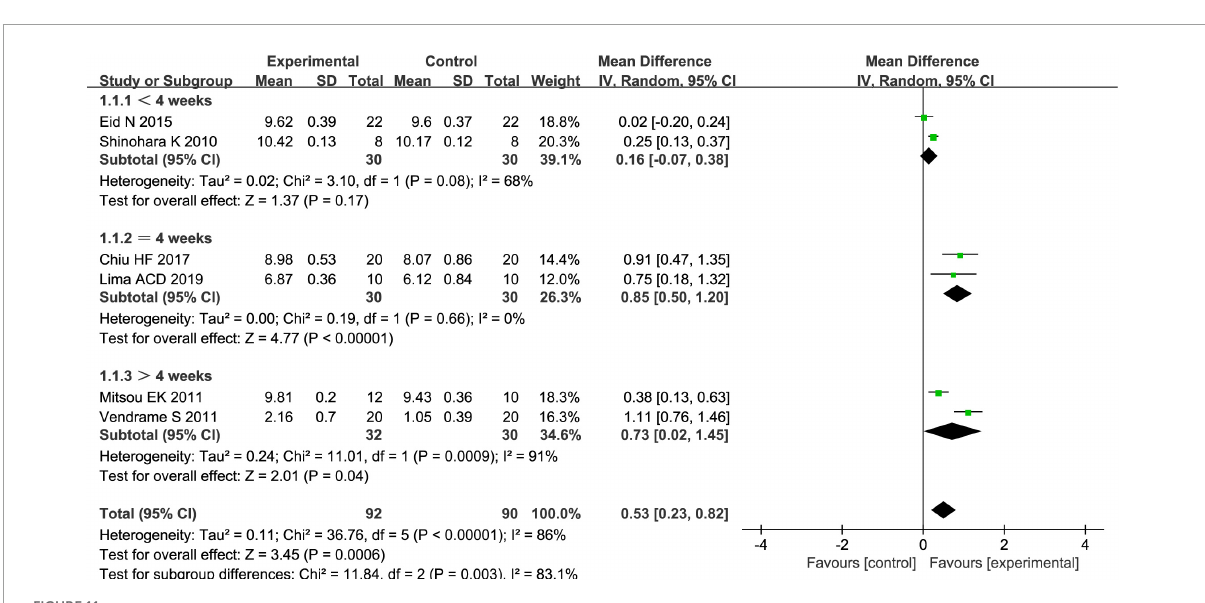
FIGURE11 Intervention effect of the fruits vs. placebo for Bifidobacterium on patients in subgroup meta-analysis by types of intervention